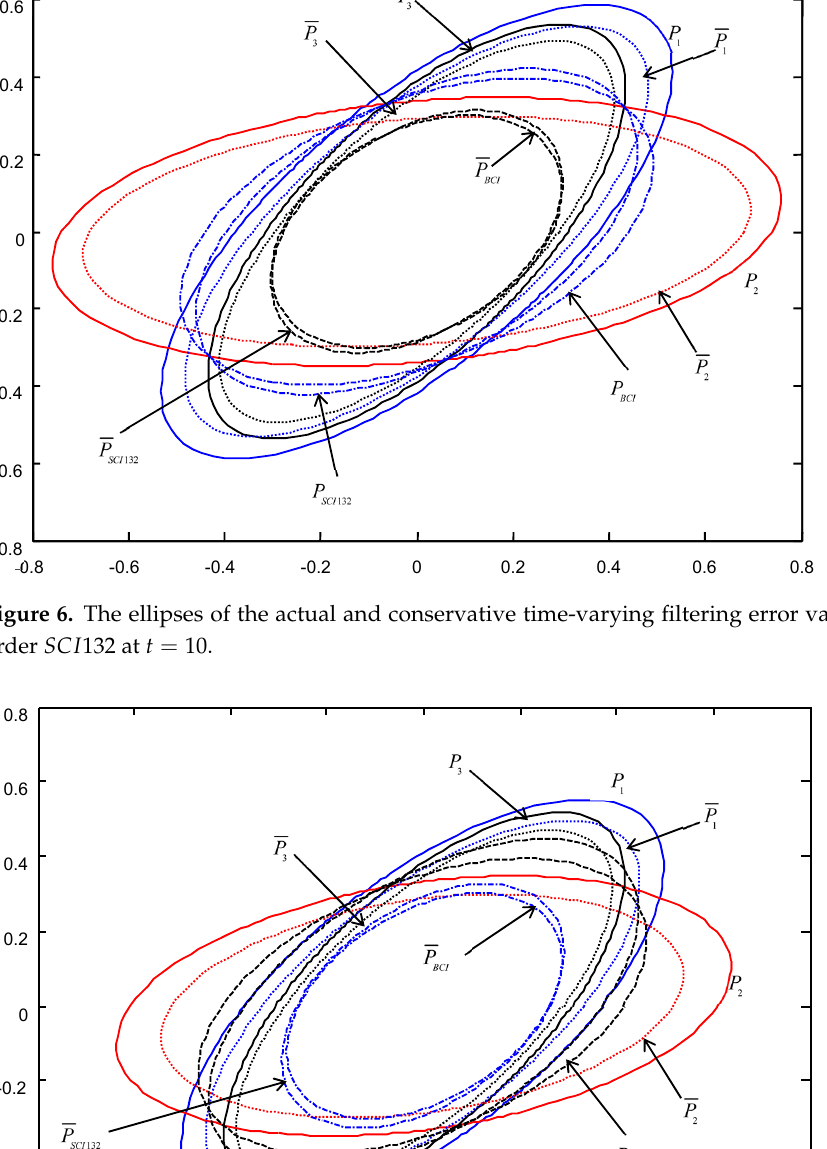
Figure 5. The ellipses of the actual and conservative steady ‐ state filtering error variances of the order .